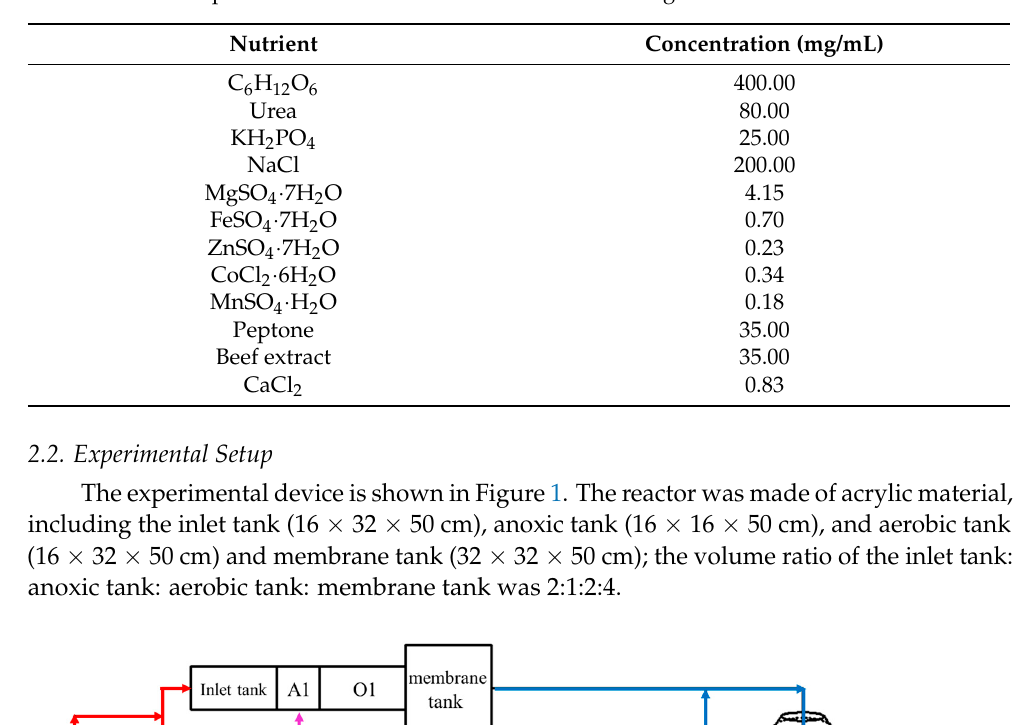
Table 1. Main composition and concentration of simulated sewage.